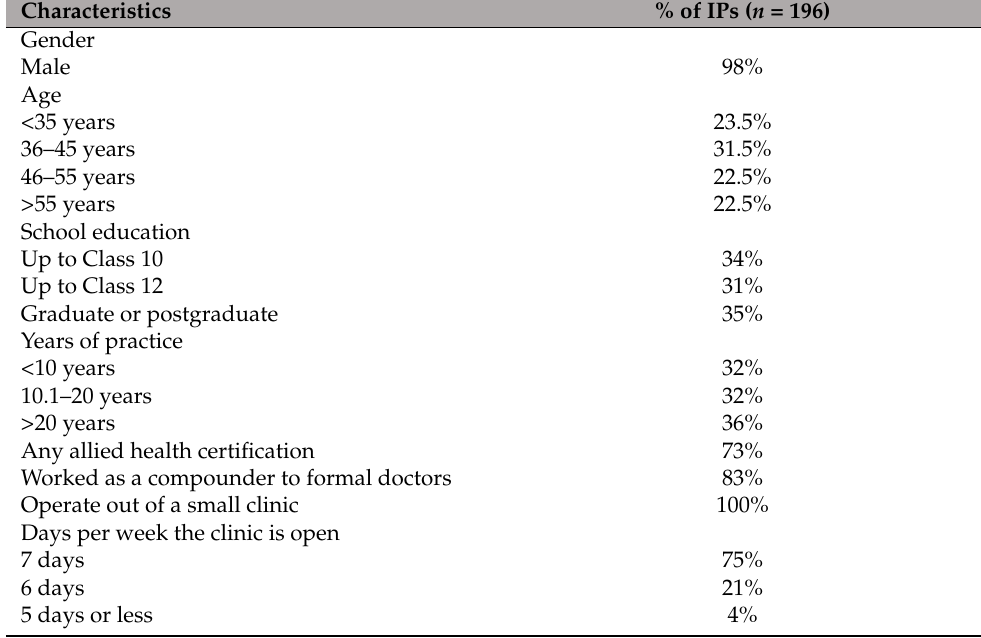
Table 1. Informal provider (IP) sociodemographic and practice